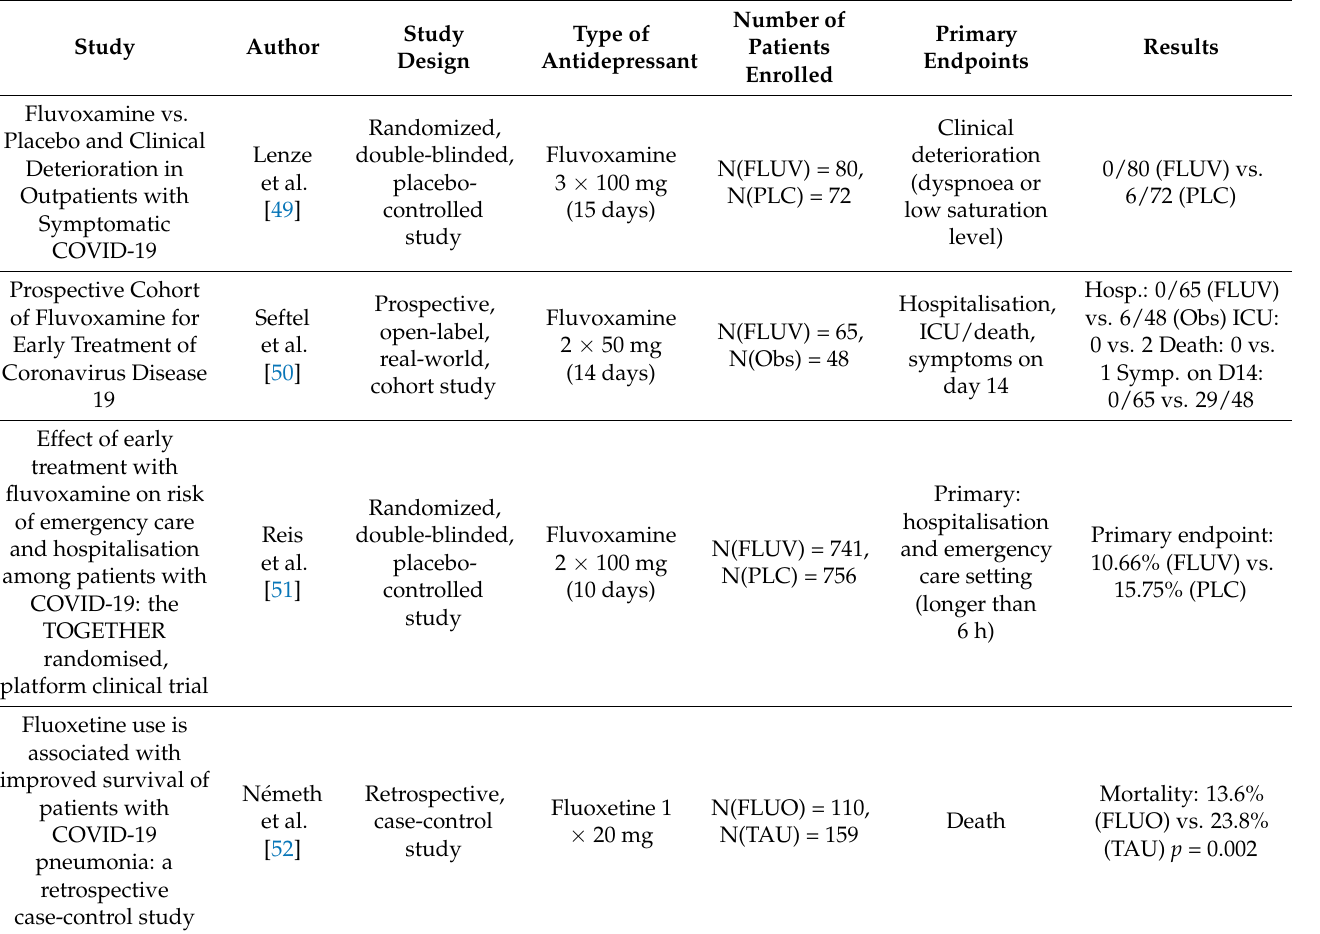
Table 1. Summary of the available clinical data on the potential benefit of fluoxetine and fluvoxamine in preventing severe